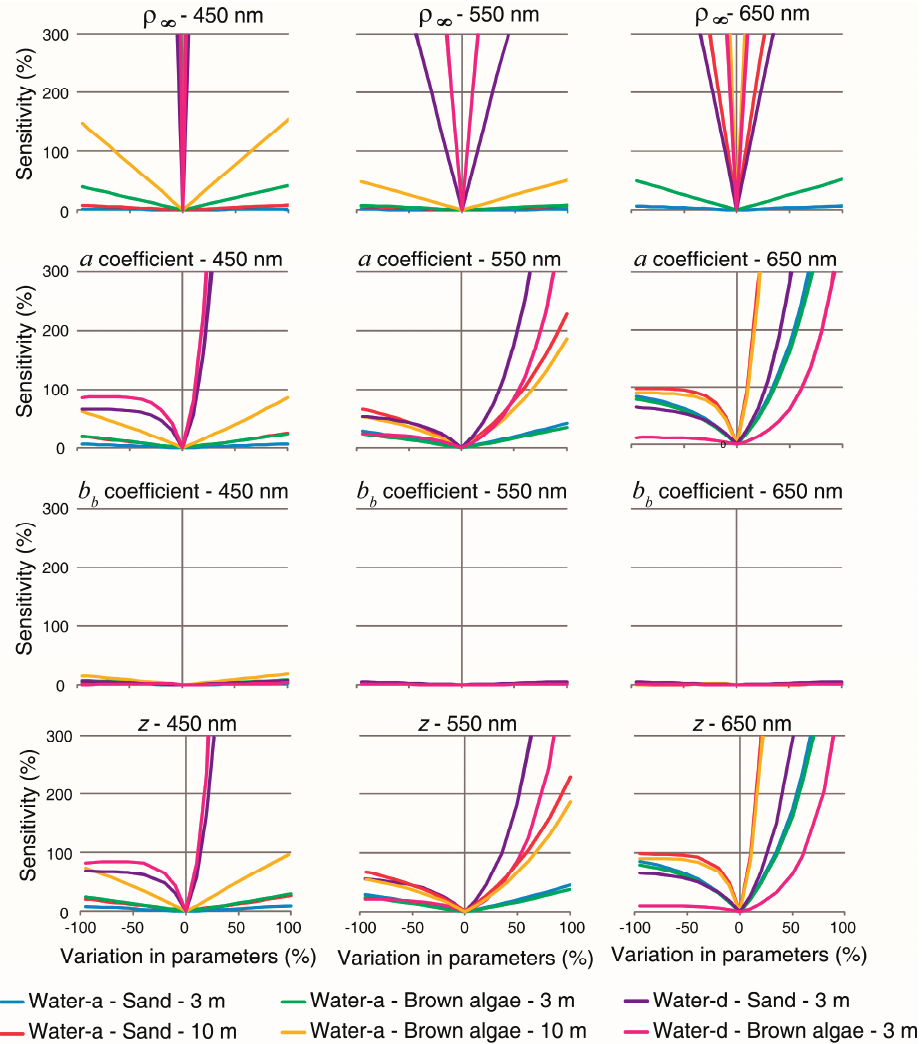
Figure 8. Sensitivity analyses for parameters of L99: ρ to sensitivity (in %) defined in Equation (14). Results are arranged by parameter and wavelength (450, 550 and 650